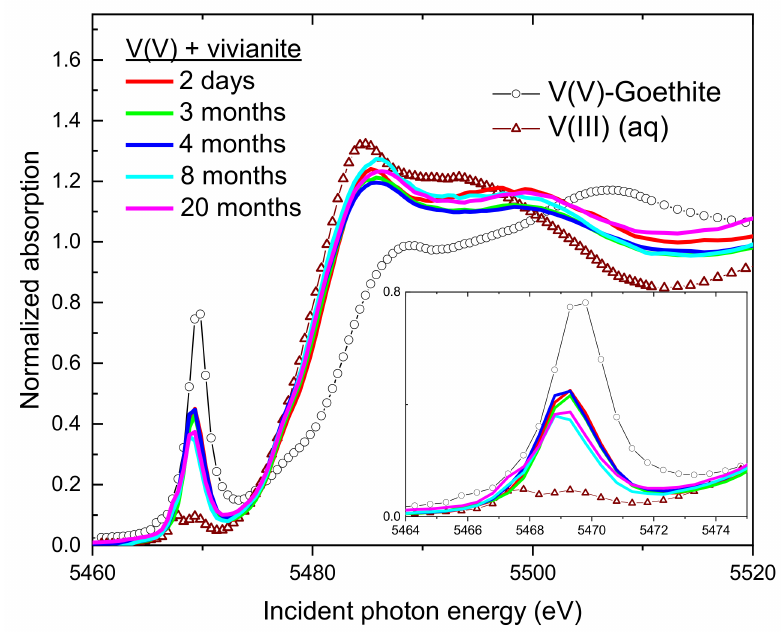
Figure 5. The V K-edge XANES spectra of the solids in the vivianite system over time compared to representative standards V(V) sorbed to goethite and aqueous V(III). Inset shows details in the pre-edge